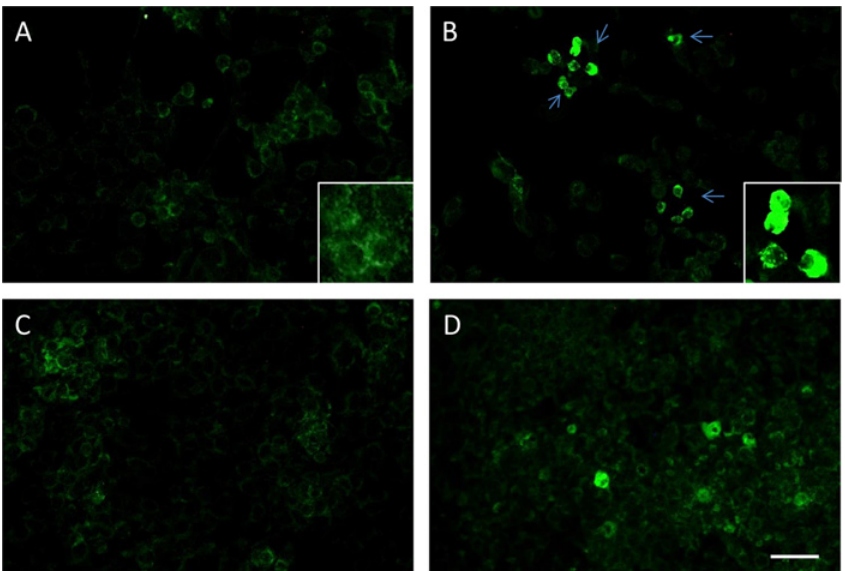
Fig 6. Involvement of AIF in CSE-induced Apoptosis. PBECs were left untreated (A), or were treated for 24h with 20% CSE alone (B), or with a combination of CSE and GSH (1mM) (C) or AA (250nM) (D). Cells were then washed, fixed and stained with a primary antibody directed towards AIF, followed by a secondary FITC-conjugated antibody. The figure shows that in basal conditions, PBEC expressed AIF in their cytoplasm especially inside their mitochondria (A, insert); CSE treatment caused translocation of AIF from the mitochondria to inside the nuclei (B, green arrows and insert); GSH pre-treatment caused a significant decrease in the number of nuclear-AIF positive cells whereas AA was not so effective. Bar = 30 μ m. Data are representative of experiments performed with PBECs from 2